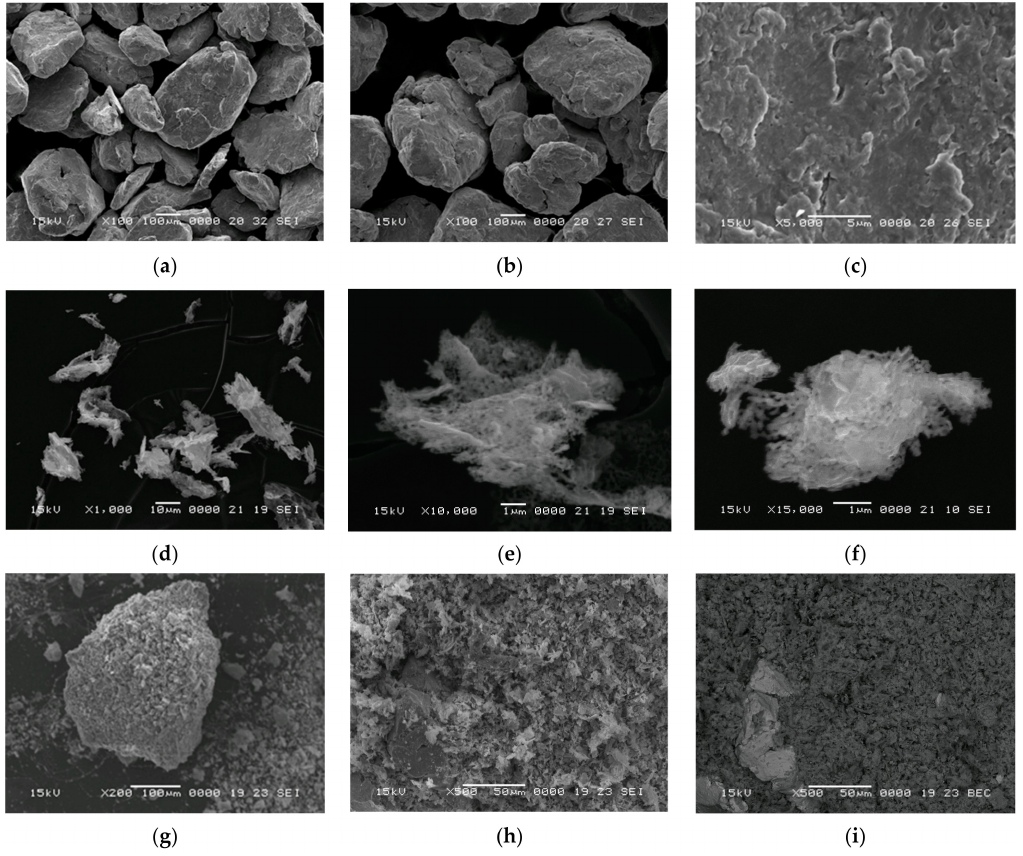
Figure 2. Scanning electron microscopy images of 12 h milled Ni 3 Fe ( a , c ), and supermalloy ( b ), nanosized Mn 0.5 Zn 0.5 Fe 2 O 4 ( d – f ) and Ni 3 Fe@Mn 0.5 Zn 0.5 Fe 2 O 4 pseudo core–shell powders.